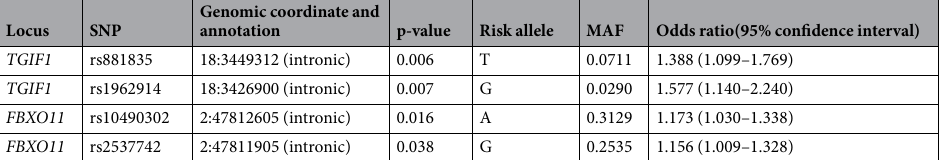
Table 3. Results of TDT association testing for the SNPs evaluated in the UK cohort. Only the top four hits are shown, data for all SNPs tested are shown in Supplementary Table S1. MAF = Minor Allele